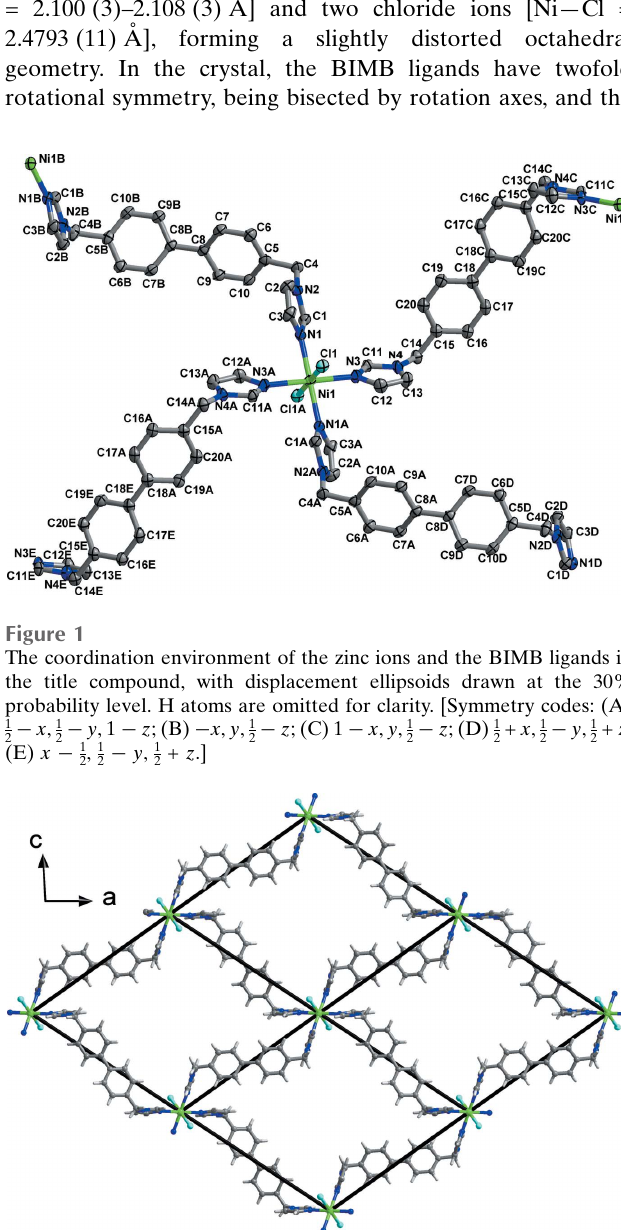
Figure 4 View of the C—H (cid:2)(cid:2)(cid:2) Cl hydrogen bonds (dashed lines) between alternate layers along the c axis. H atoms not involved in hydrogen bonding are